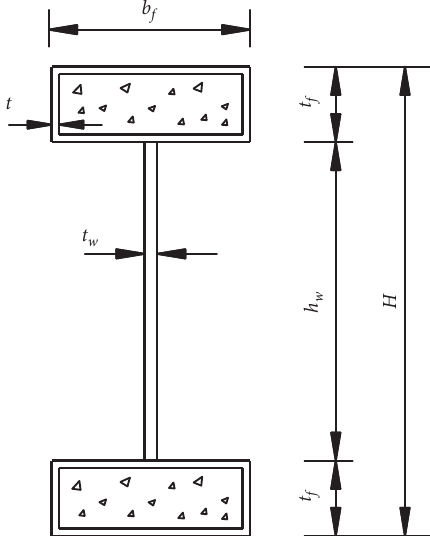
Figure 4: Diagram of section